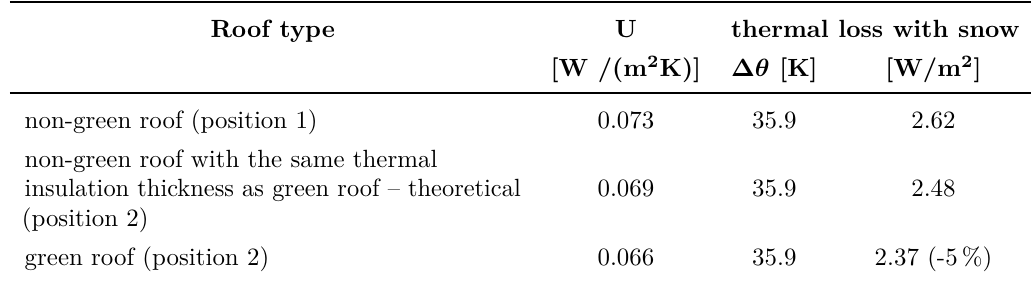
Table 4. Calculated thermal loss with snow based on the measured surface temperatures (Figure